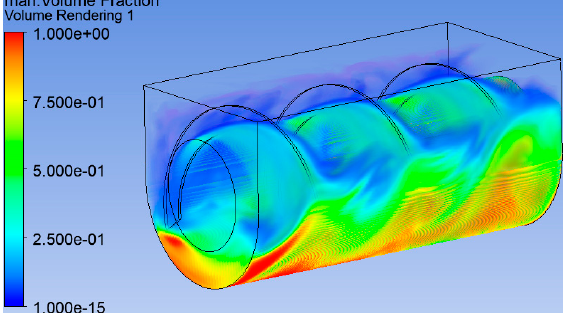
Figure 9. Convergence test.